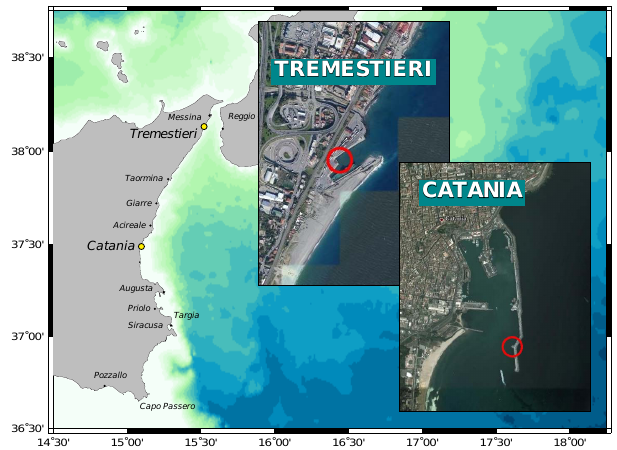
Fig. 2. Location and map of the Tremestieri and Catania harbours (map data: Google, TerraMetrics, DigitalGlobe). The tide-gauge station is indicated by a red circle.